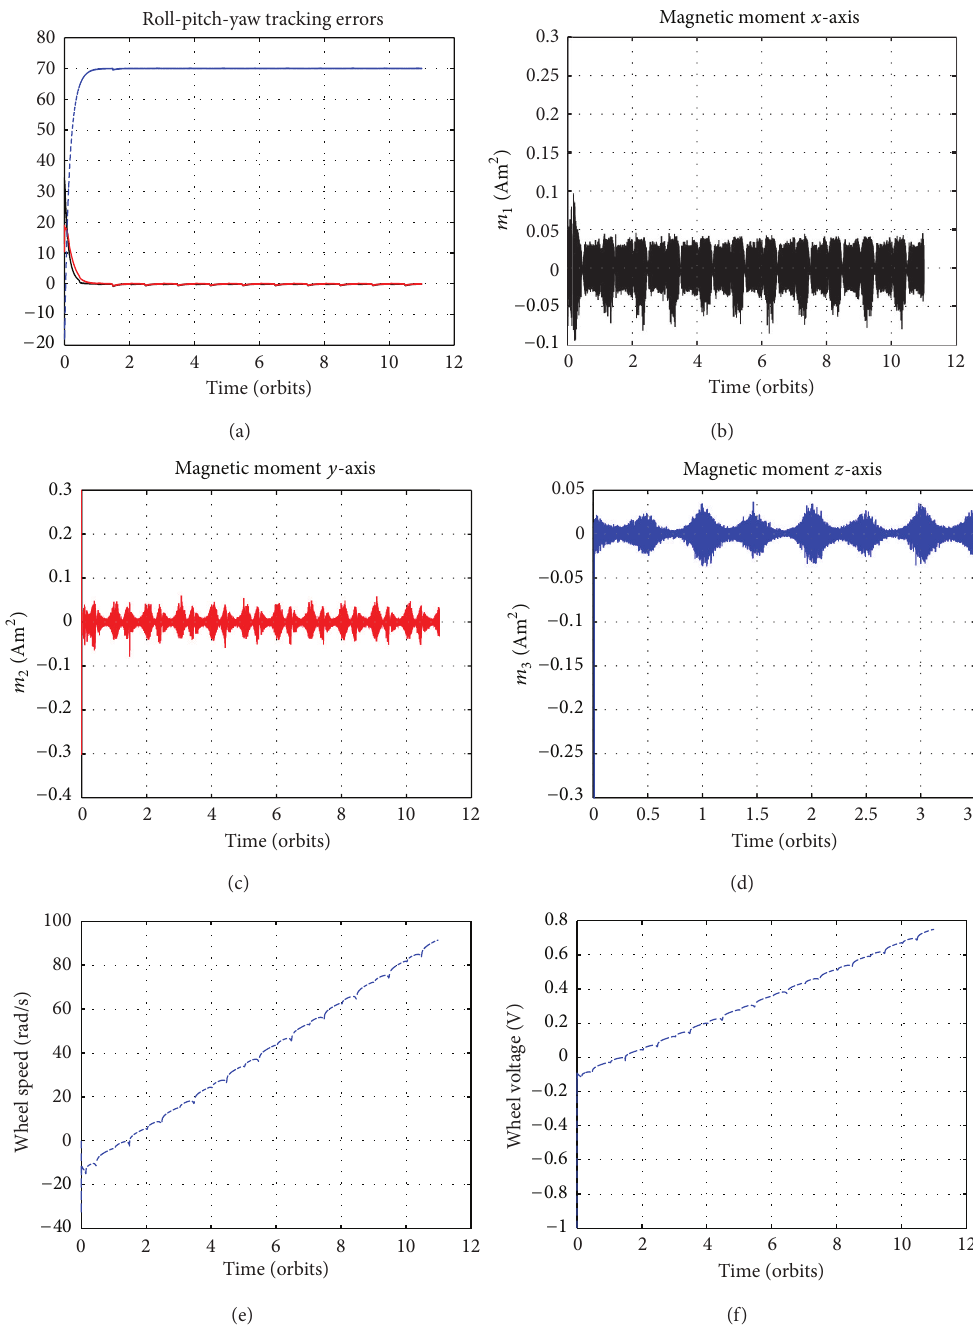
Figure 9: Scenario 3 limb pointing control results using one reaction wheel and three magnetorquers.